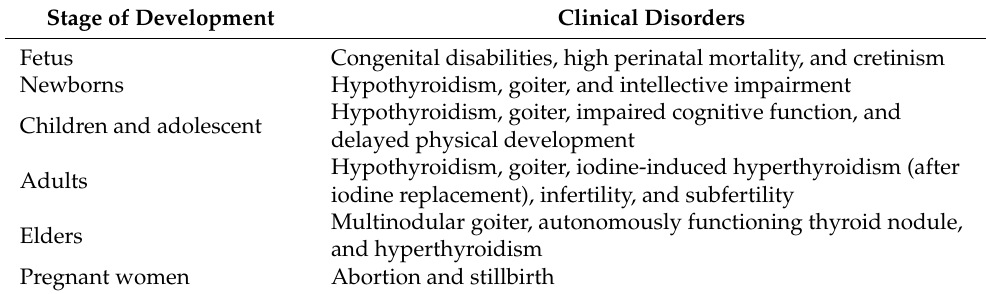
Table 2. Overview of iodine deficiency disorders by age